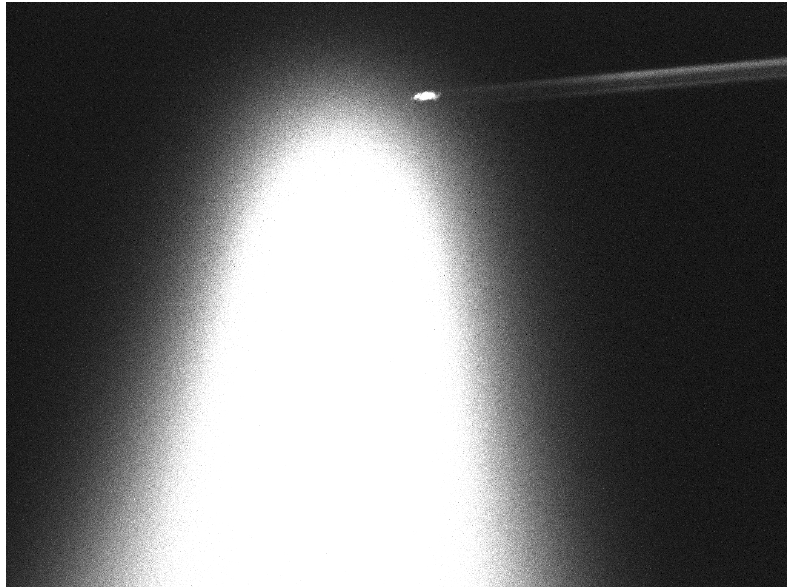
Figure 10. Laser tracking of the CryoSat-2 satellite using two SLR systems at CBK